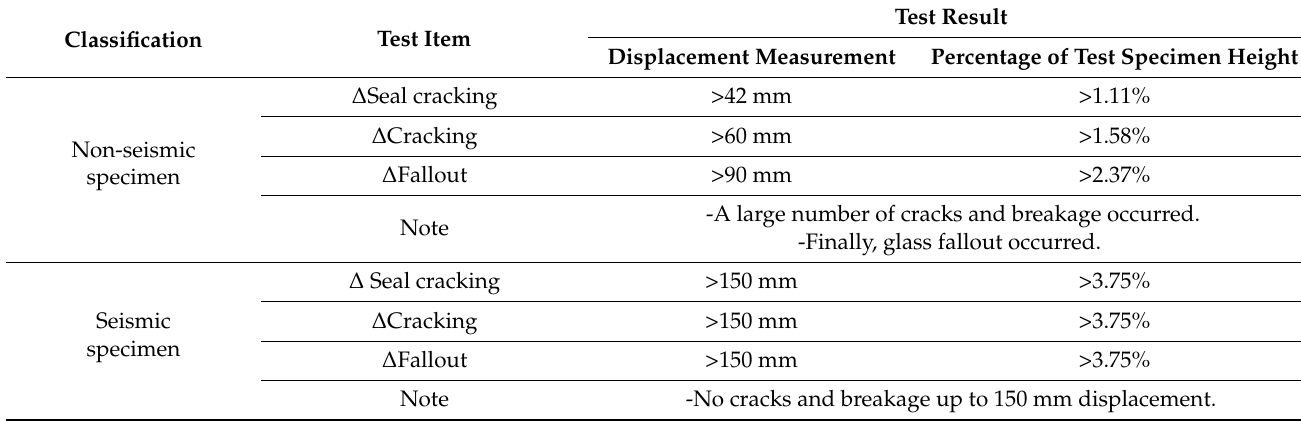
Table 6. Dynamic racking crescendo test results.